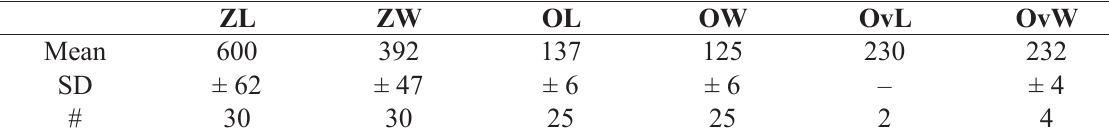
Table 4. Measurements of Atlantisina inarmata gen. et sp.